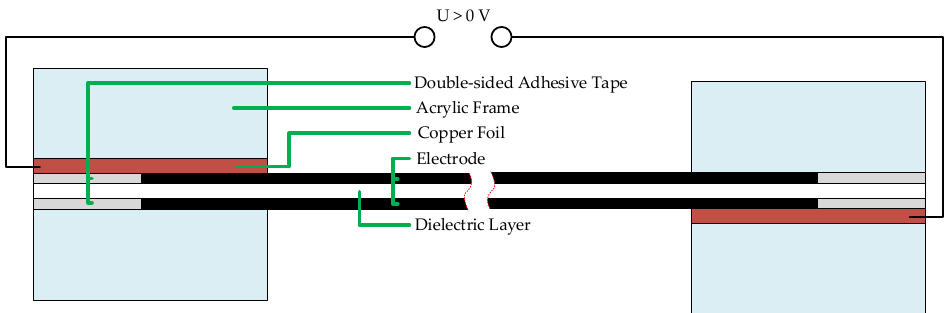
Figure 3. Test setup inside the temperature chamber with 3D-printed insert clamp holder and DEA sample.